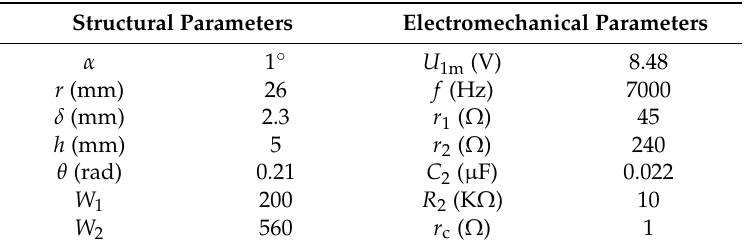
Figure 4. The equivalent electric and magnetic circuits when the rotor rotates clockwise at an angle of α away from the zero position. Table 1. The parameters in the simulation.